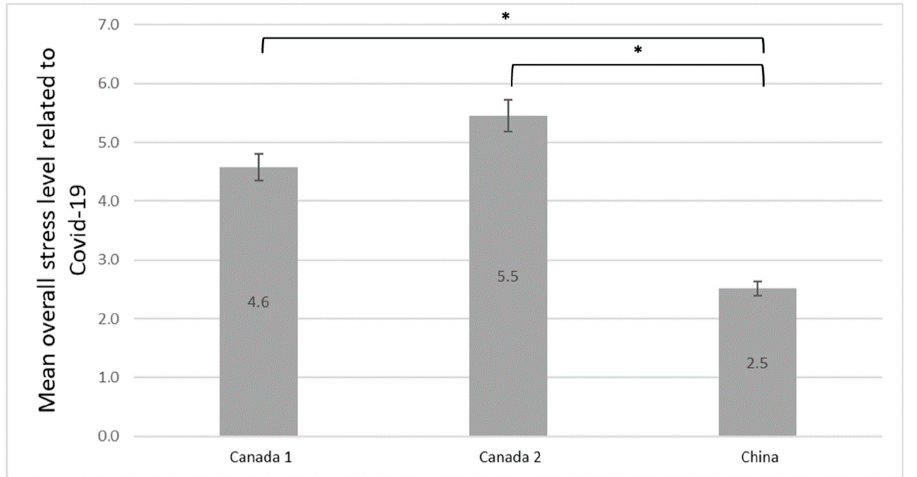
Figure 4. Overall maternal stress level related to COVID-19. * p < 0.001 (between Canada 1/China) and between Canada 2/China. Canada 1 (Can1), n = 1541; Canada 2 (Can2), n = 119; China, n = 448. missing values: Canada 1, n = 263 ; Canada 2, n = 16 ; China, n = 36.